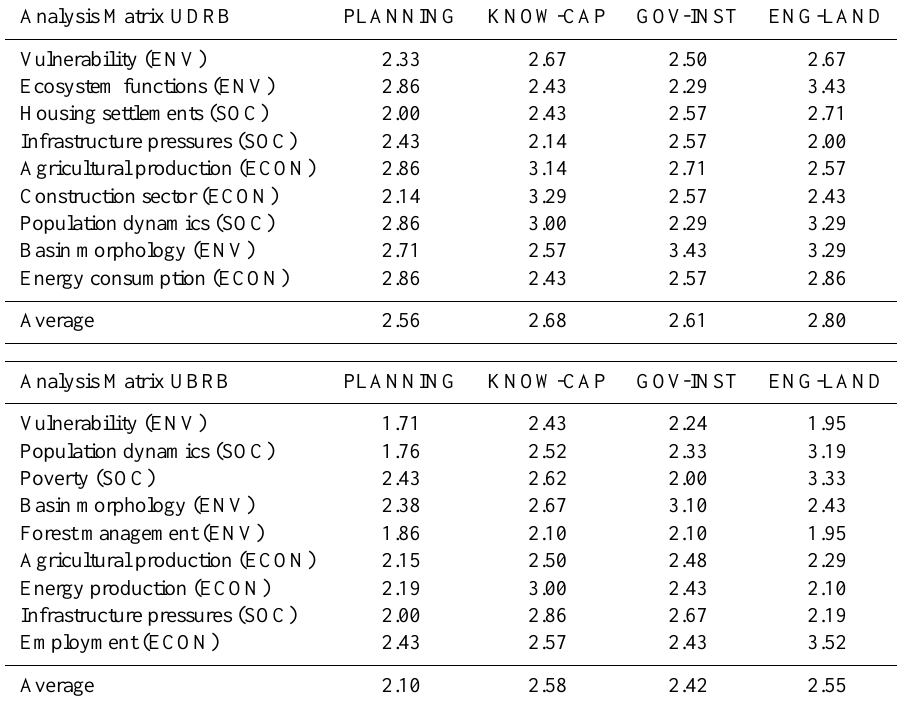
Table 2. Analysis Matrices: average values of LAs’ evaluations on the potential e ff ectiveness of each response in coping with the issues expressed by the criteria (rows) by means of a Likert scale ranging from 1 “Very high e ff ectiveness” to 5 “Very low e ff